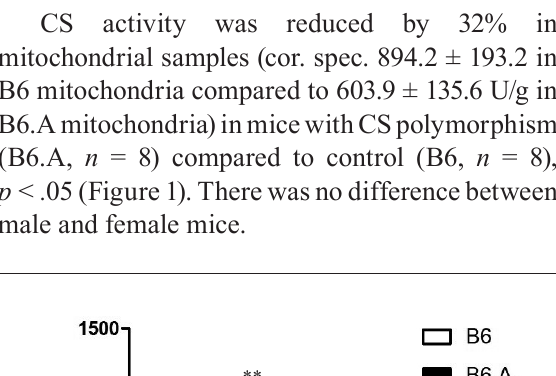
Figure 3. Comparison of three muscle mitochondria respiration states between B6 and B6.A